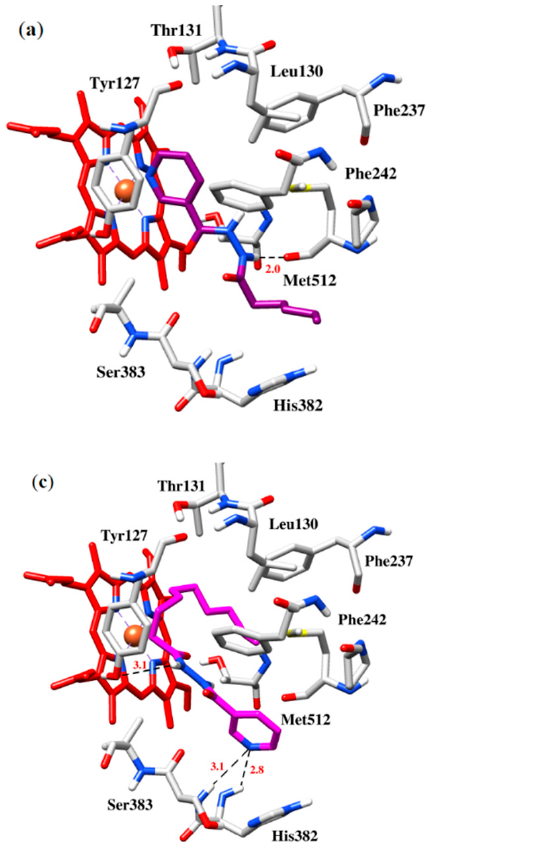
Figure 10. Binding poses of 5 – 7 and 10 are depicted in panels ( a − d ) in alphabetical order and amino acid residues of antifungal target protein CYP51 (light grey) from Candida glabrata . The dashed black lines depict hydrogen bond interaction.